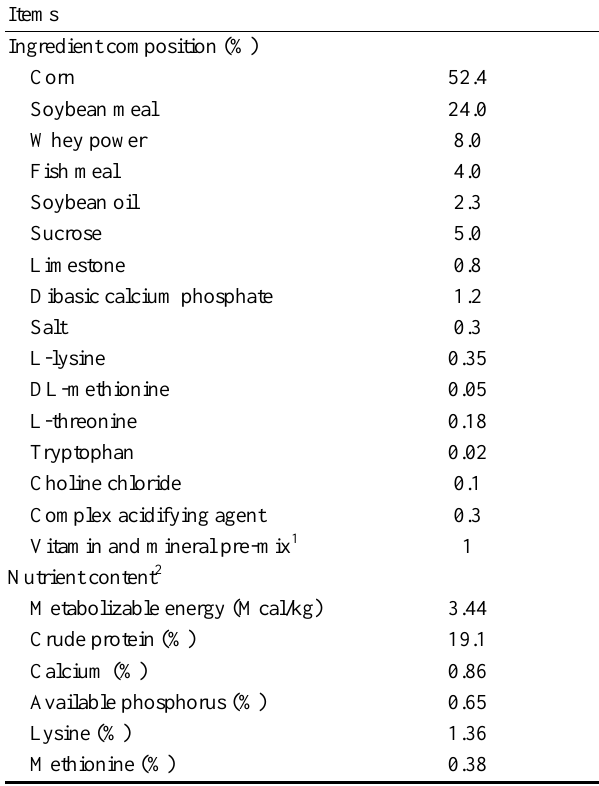
Table 1. Ingredient composition and nutrient contents of the basal diet (%, as-fed